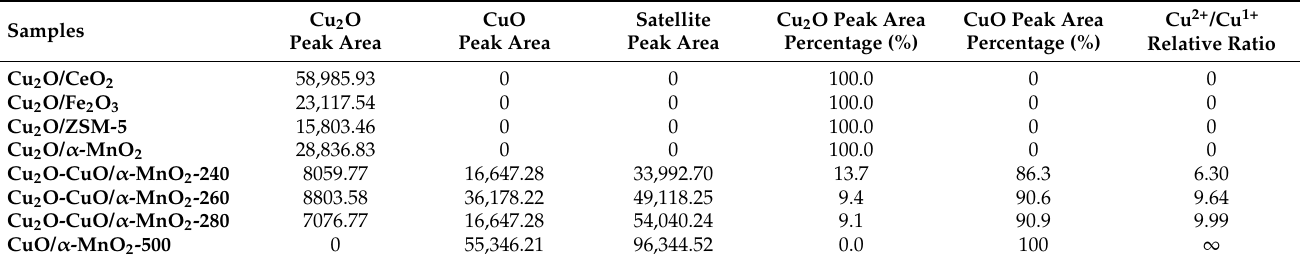
Table 4. Cu 2p peak area of the as-prepared Cu 2 O/S (S = α -MnO 2 , CeO 2 , SBA-ZSM-5, Fe 2 O 3